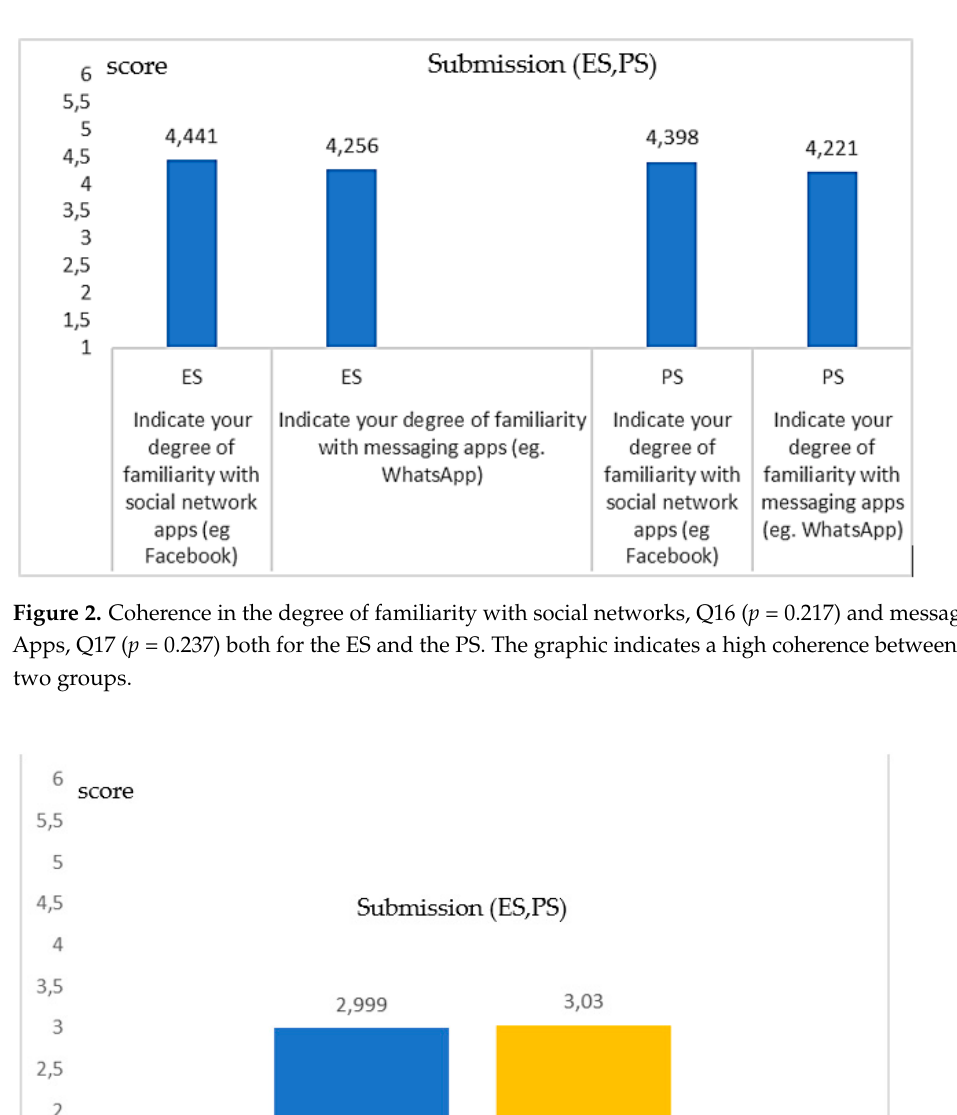
Figure 3. Coherence in the degree of familiarity with the App Immuni for digital contact tracing (DCT) both for the ES and the PS ( p = 0.284). The graphic indicates a high coherence between the two groups.